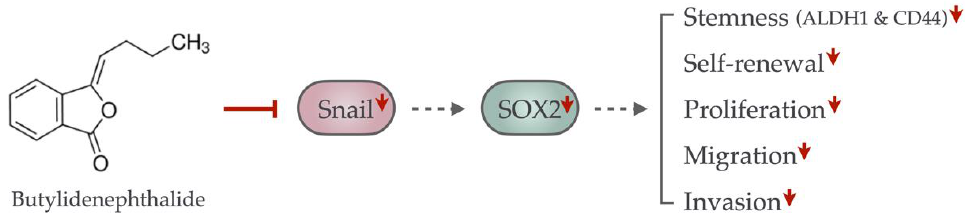
Figure 7. The graphic abstract of the present study illustrates the mechanism of butylidenephthalide to eliminate oral CSCs by suppressing the Snail-induced cancer stemness properties. The administration of butylidenephthalide suppressed the Snail expression, resulting in the downregulation of SOX2 expression, thereby abolishing the stemness markers’ expression, self-renewal, proliferation, migration, and invasion of oral CSCs. Red, solid line with vertical head indicates the inhibiting effect; gray, dotted line with arrowhead indicates the weakened increasing effect; red arrowhead indicates the downregulation.